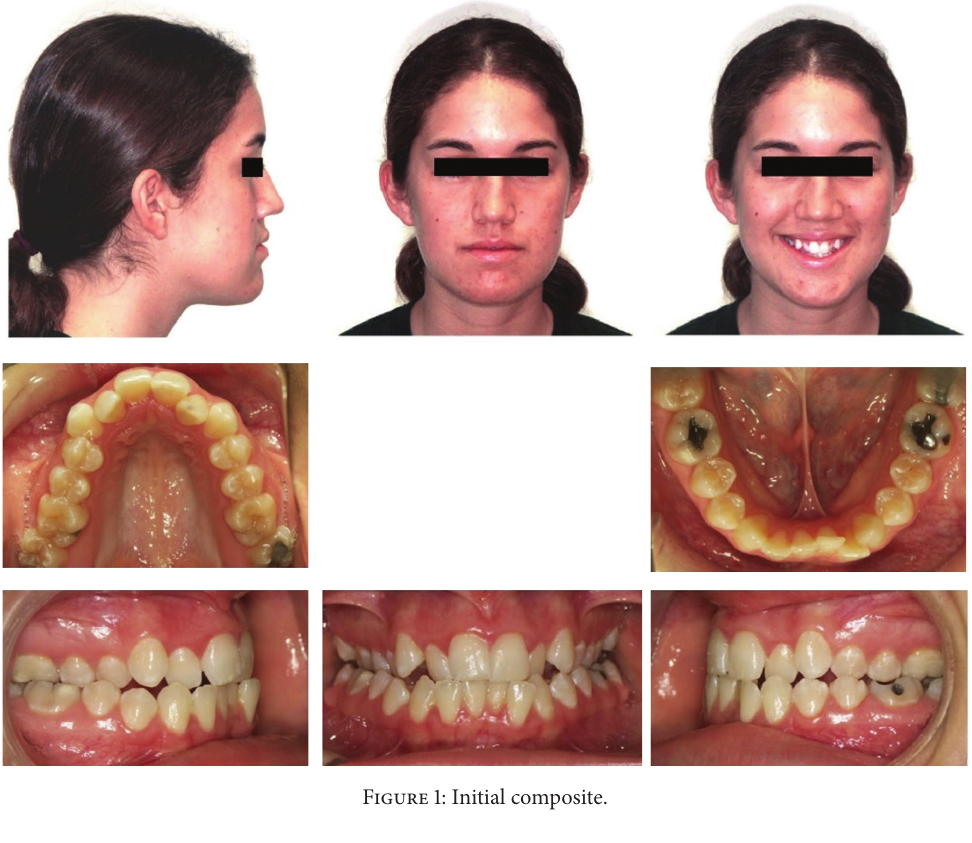
Figure 1: Initial composite.